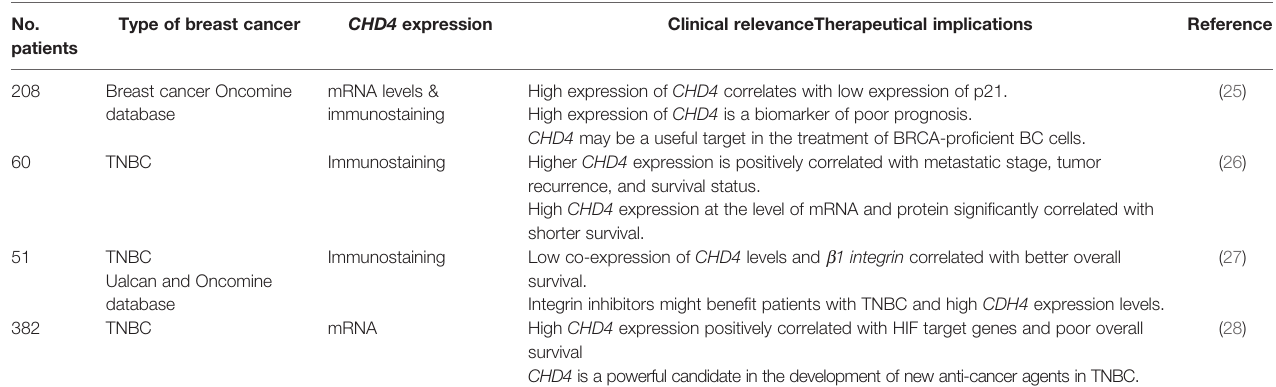
TABLE 3 | Summary of studies describing the clinical relevance of CHD4 expression as a biomarker of prognosis in different breast cancer patients. No. Type of breast patients